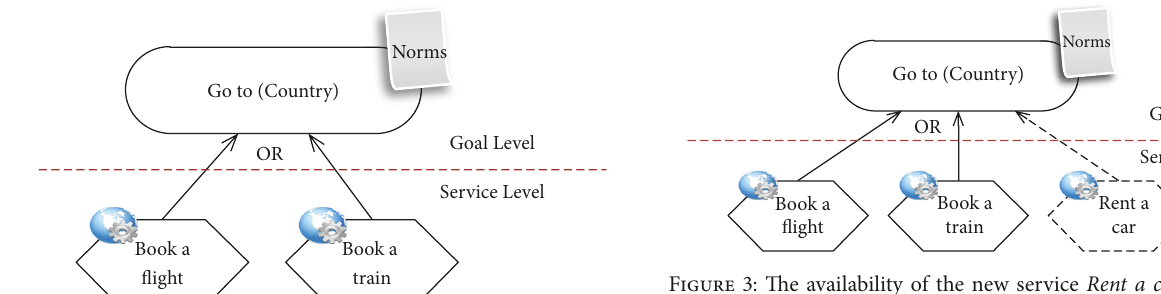
Figure 3: The availability of the new service Rent a car gives the system a new mean for satisfying the goal Go to (country)